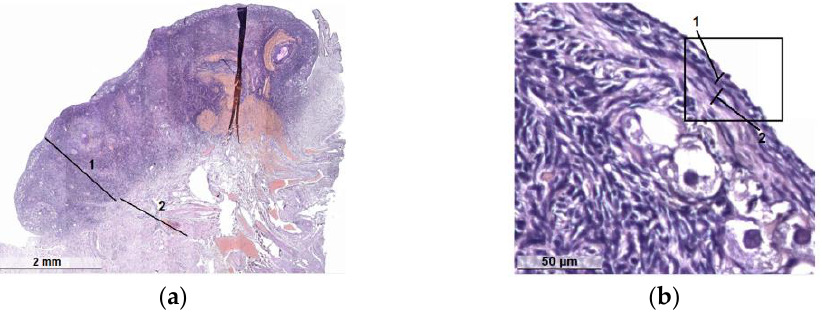
Figure 5. Histology of clinically healthy cat ovaries: ( a ) cortex (1) and medulla (2) in the light ovary (follicular phase); ( b ) the structure of the membrane of the dark ovary (luteal phase): single layer cuboidal epithelium (1) and subepithelial albuginea (2).